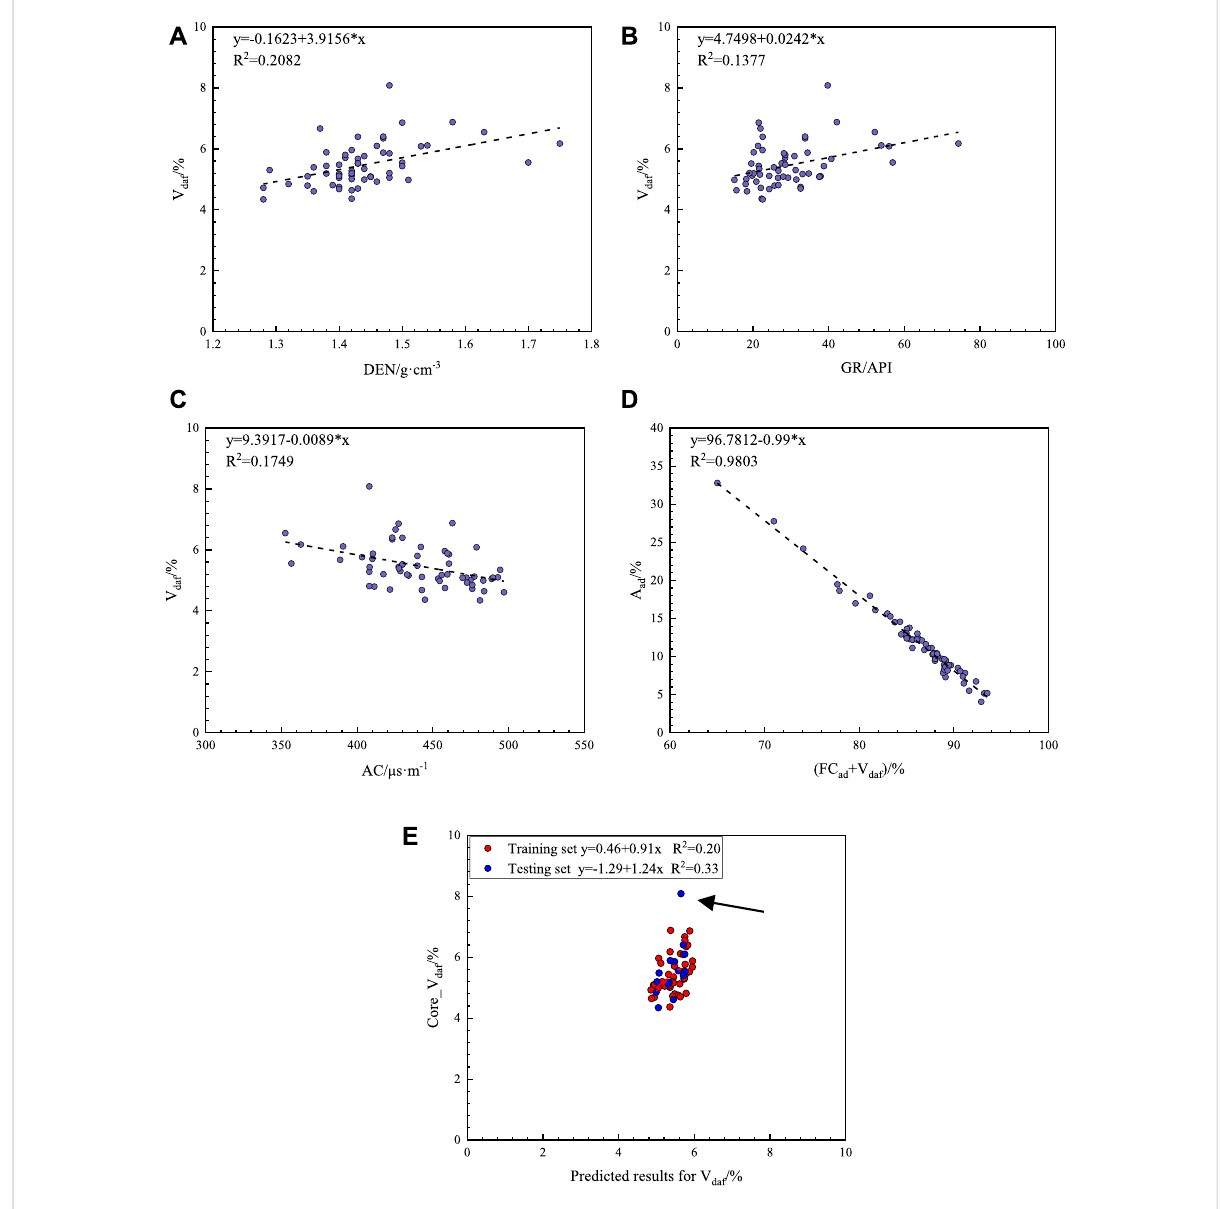
FIGURE 6 Correlation analysis of the Vd af content and the geophysical logging data response with the predicted results of the Vd af content. (A) Relationship between the Vd af content and DEN. (B) Relationship between the Vd af content and GR. (C) Relationship between the Vd af content and AC. (D) Autocorrelation between industrial component contents. (E) Performance of the OBGM (1, 6) prediction model on the training and test sets for the Vd af